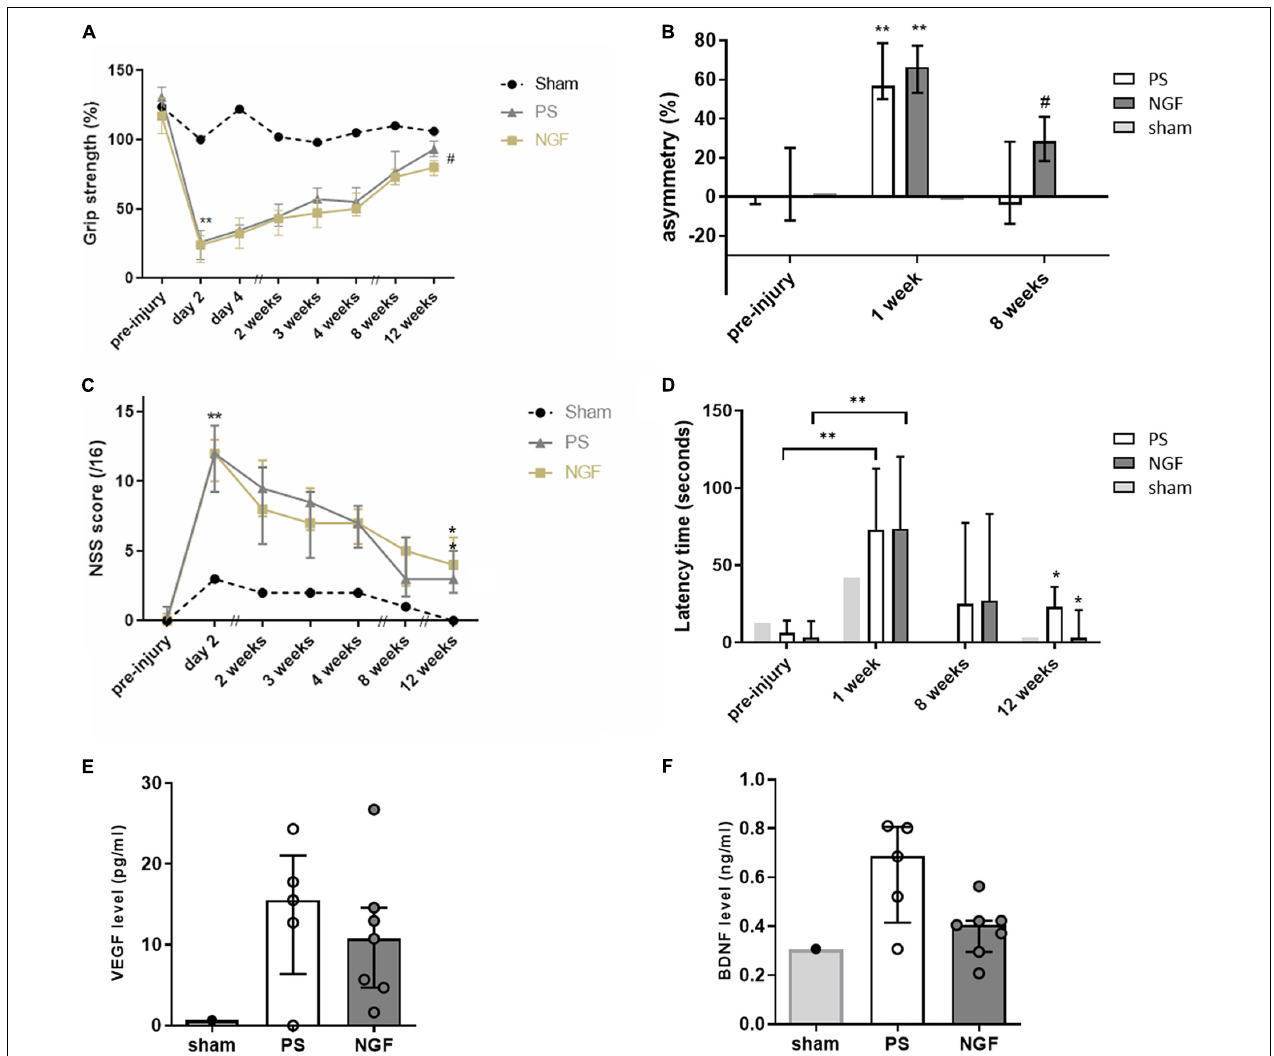
FIGURE 9 | Behavioral tests following injury to the sensorimotor cortex. (A) Grip strength test shows the grip strength of the front paw contralateral to the injected hemisphere compared to the other paw, expressed as %. The Wilcoxon test compares the values measured 2 days post- compared to the pre-injury ones for the PS (gray triangles) and NGF (light yellow squares) groups (** p < 0.01). The Bonferroni corrected Mann Whitney test compares the results between the PS and the NGF groups, significant at 12 weeks post-injury ( # p = 0.014). (B) The limb-use asymmetry test measures the asymmetric limb use, meaning the difference of use for the ipsilateral - contralateral paws compared to the number of supports in %. Both groups were significantly impaired on the contralateral limb 1 week post-injury compared to pre-injury values (Wilcoxon test, ** p < 0.01). The difference between PS (white bars) and NGF (dark gray bars) groups is significant 8 weeks post-injury (Mann Whitney test, # p < 0.05). (C) The NSS shows the sensorimotor deficits after malonate injection (scored out of 16). Both groups were significantly impaired 2 days post-injury compared to pre-injury values (Wilcoxon test, ** p < 0.01). A significant improvement in NSS was observed in both groups [PS (gray triangles) and NGF (light yellow squares)] 12 weeks compared to 2 days post-injury ( ∗ p < 0.05). (D) The anxiety test showing that the latency to take out two front limbs was significantly increased between the pre-injury and 1 week post-injury values for both groups [PS (white bars) and NGF (dark gray bars)] (Wilcoxon test, ** p < 0.01). The latency significantly decreased between 1 week and 12 weeks post-injury in both groups, independently of the treatment ( ∗ p < 0.05). The Mann-Whitney test did not show any difference between the two groups 12 weeks post-injury. The graphs show the median values and their interquartile ranges; For (A–D) , sham: n = 1; PS group: n = 9; NGF group n = 9; n corresponds to the number of individuals. (E,F) Notch box plots showing the level of VEGF ( left ) and BDNF ( right ) measured in the plasma of PS and NGF groups 12 weeks post-injury. The graphs show the distribution of individual values and the median and the interquartile range. PS group: n = 5; NGF group n = 7. PS: physiological saline; NGF: nerve growth factor; NSS: neurological severity scale; VEGF: Vascular endothelial growth factor; BDNF: brain-derived growth